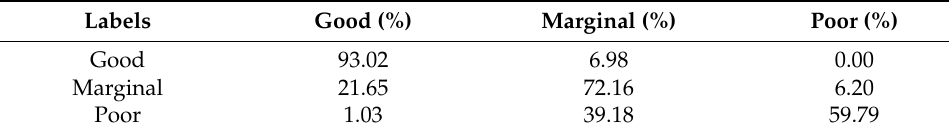
Table 3. The confusion matrix of the best performing model (VGG19) for Dataset A.